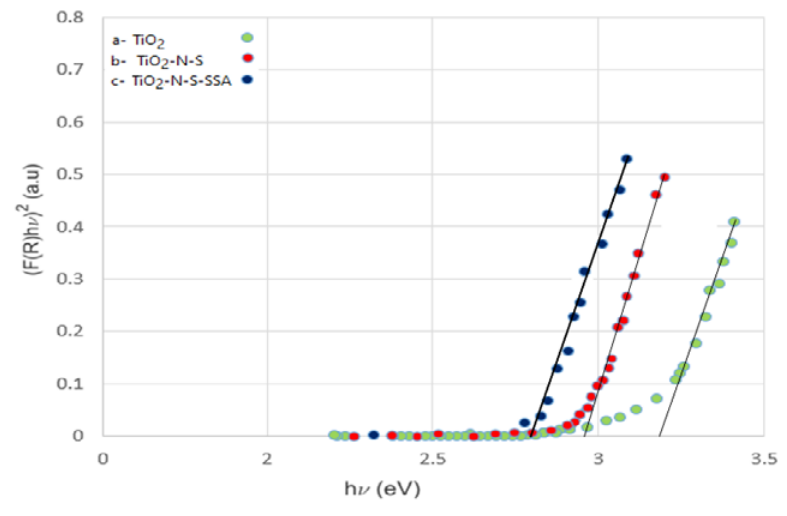
and N,S-TiO /SSA thin film; DRS spectrum of 2 2